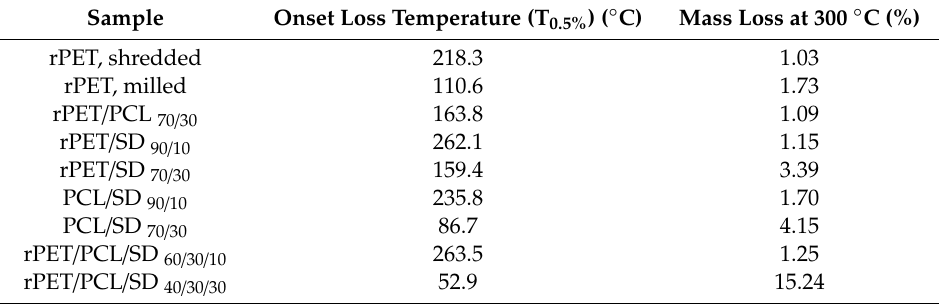
Table1. ThermogravimetricdataforrPET,rPET / poly( ε -caprolactone)(PCL)blend,andSD-filledcomposites. Sample Onset Loss Temperature (T 0.5% ) ( ◦ C) Mass Loss at 300 ◦ C (%) rPET,